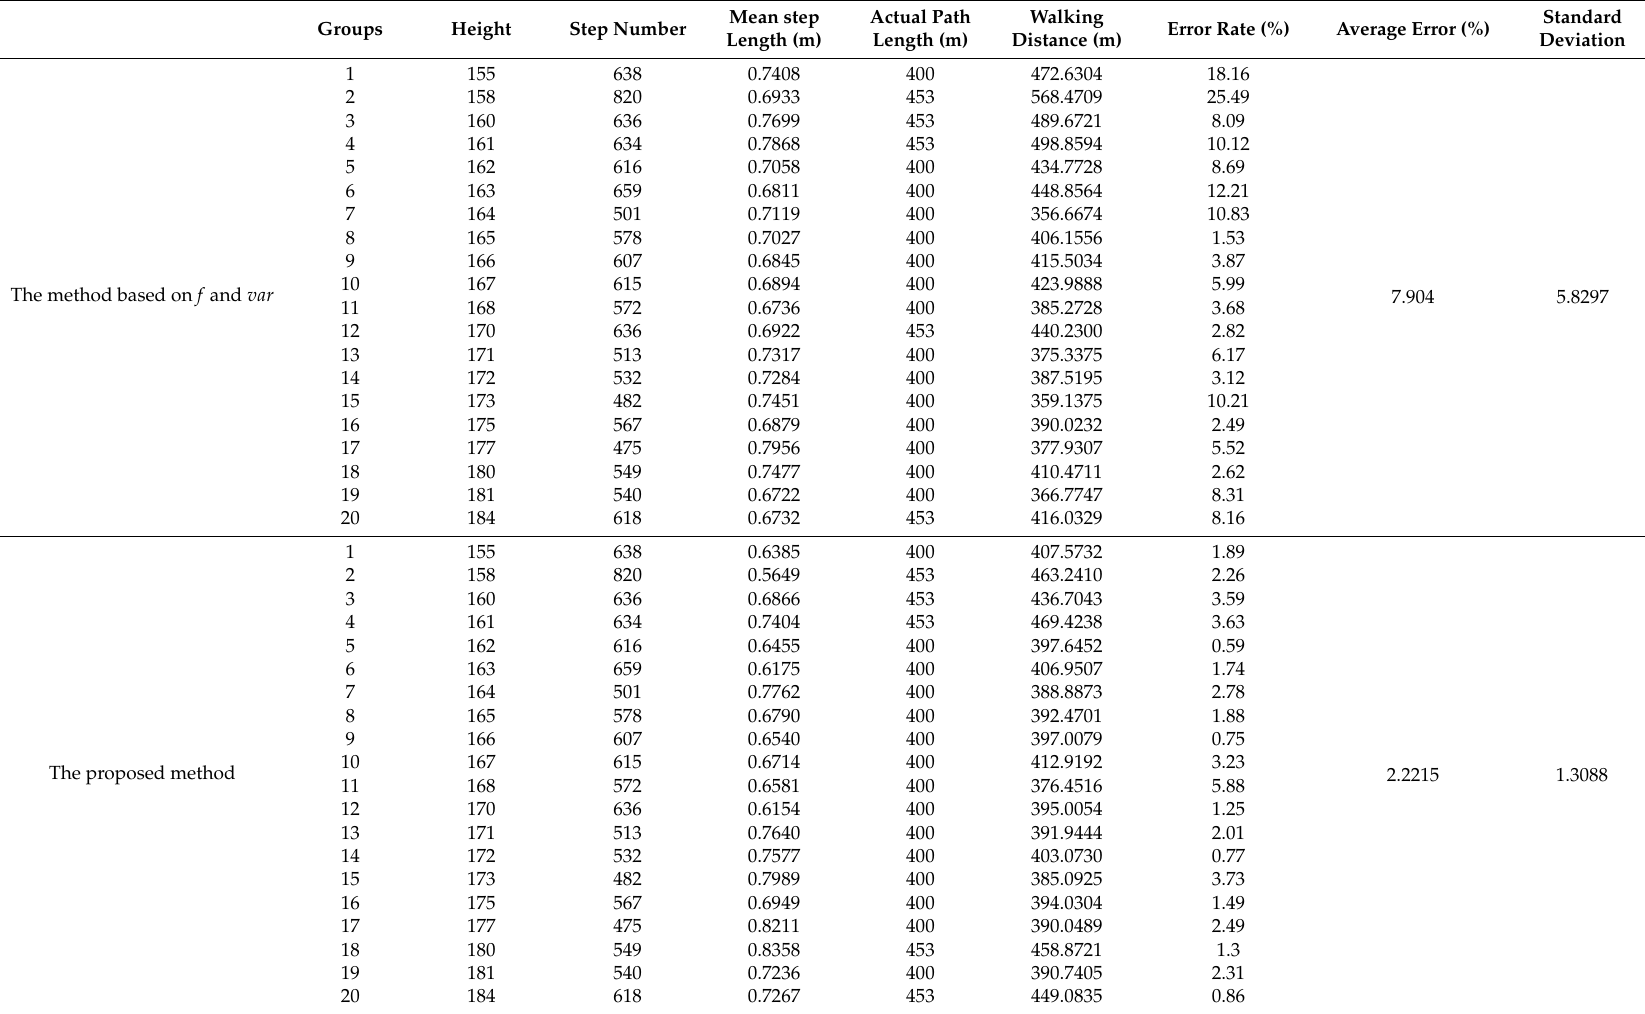
Table 2. The results of the walking